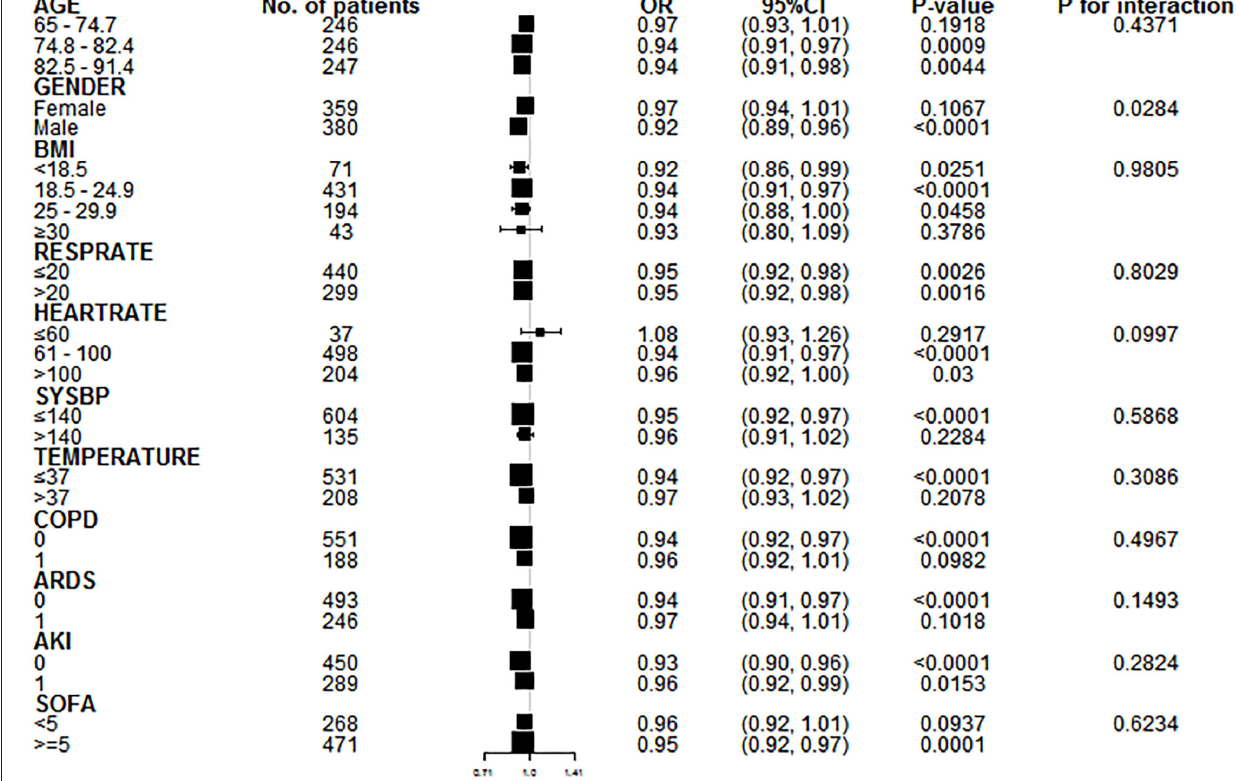
FIGURE 4 | Subgroup analysis of patients with GNRI < 92. A further subgroup analysis of 739 elderly patients with GNRI < 92 is performed to verify the consistency of the relationship between Y and X. Except gender, all other variables have no interaction ( P for interaction > 0.05). In the results of gender stratification, the risk of death for older men is lower than that for older